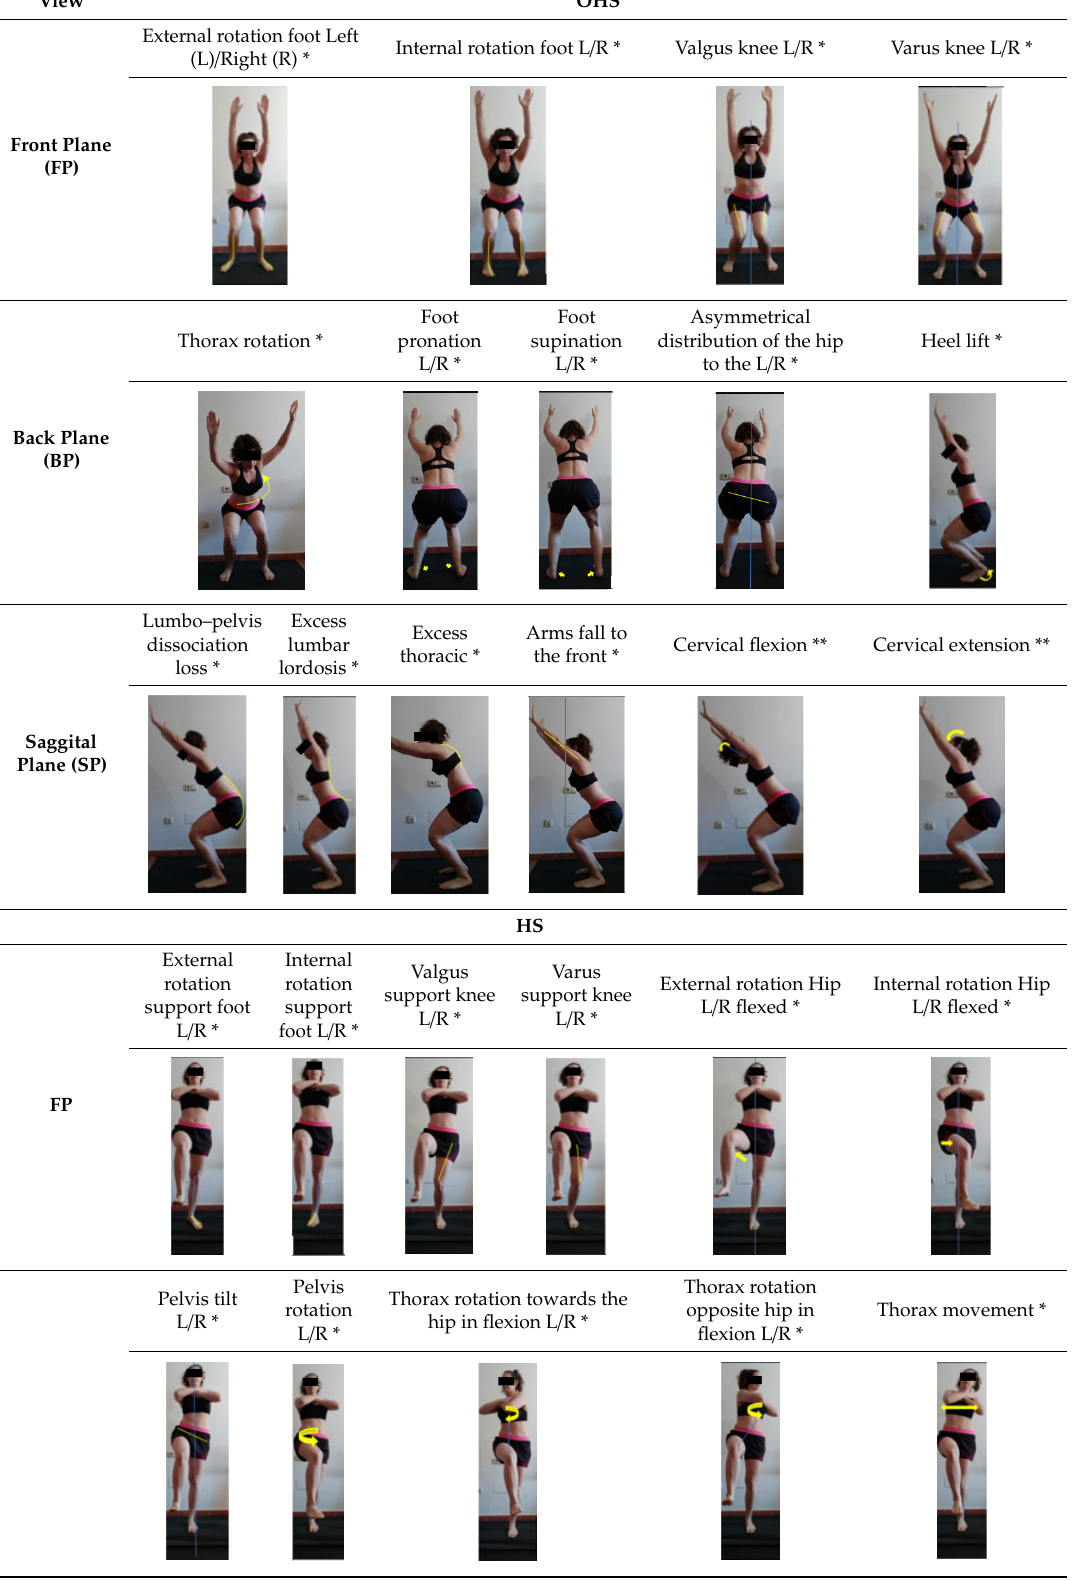
Table 2. Total compensations after review by expert.